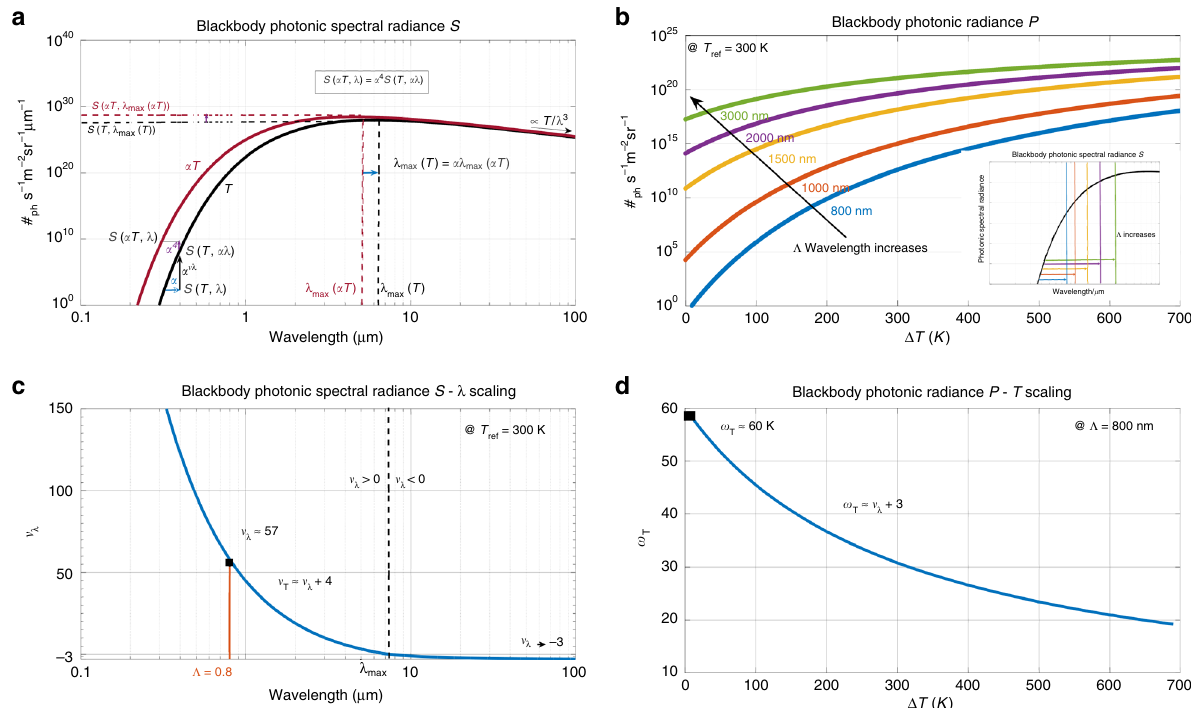
s − 1 m − 2 sr − 1 m − 1 ), as a Fig. 1 Nonlinear structure of the Planck radiation spectrum. a Blackbody photonic spectral radiance Sð T ; λ Þ in units of ( # ph ð T Þ and λ ð α T Þ , function of the wavelength for two temperatures T (400 K) and α T (500 K, α ¼ 1 : 25). The maximum emissions occur at λ max max ð T Þ ¼ αλ ð α T Þ . b blackbody photonic radiance ( # respectively, such that λ s − 1 m − 2 sr − 1 ) as a function of the temperature excess Δ T above max max ph T = 300 K, for different values of the upper boundary Λ of the spectral integration domain. The blackbody photonic radiance Pð T þ Δ T ; Λ Þ is obtained ref ref þ Δ T ; Λ Þ over different spectral domains ½ 0 ; Λ (cid:7) as displayed on the lower right insert. c The function by integrating the photonic spectral radiance Sð T ref ν ð T ; λ Þ describes the local nonlinearity exponent of Sð T ; λ Þ / λ ν λ . It is numerically computed for T ¼ 300 K. d The function ω ð T ; Λ Þ describes the local λ T ref nonlinearity exponent Pð T ; Λ Þ / T ω T . It is numerically computed for Λ = 800